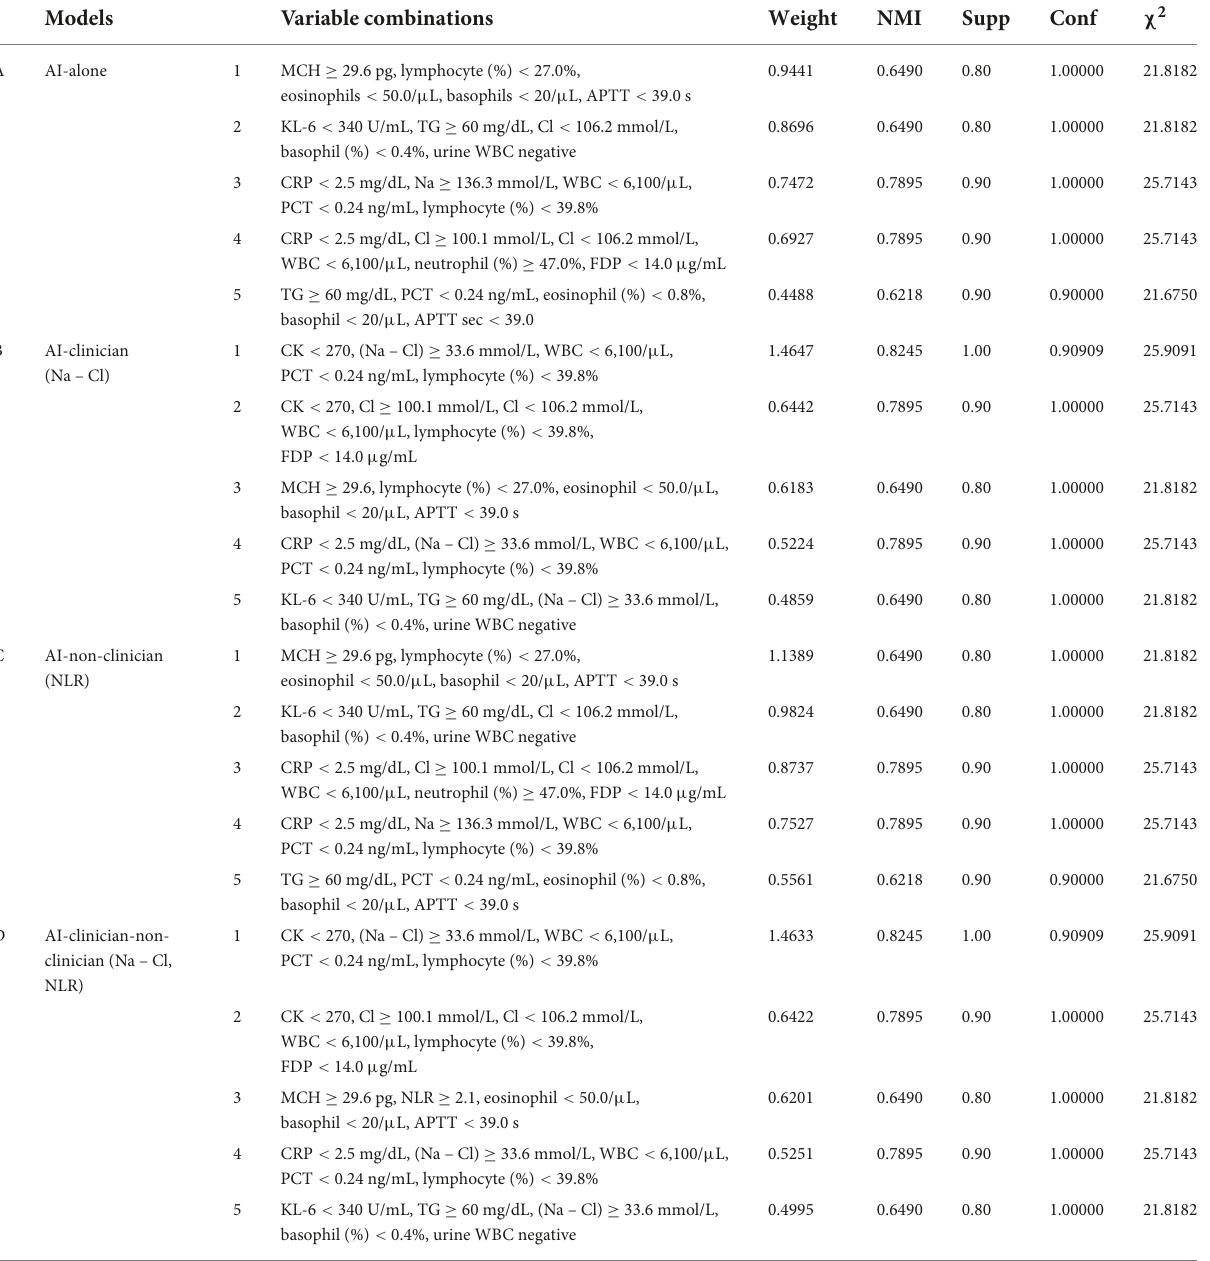
TABLE 3 Variable combinations and model performance evaluations in AI-alone, AI-clinician, AI-non-clinician, and AI-clinician-non-clinician models for predicting the need for supplemental oxygen based on characteristics and laboratory biomarkers of patients with COVID-19.